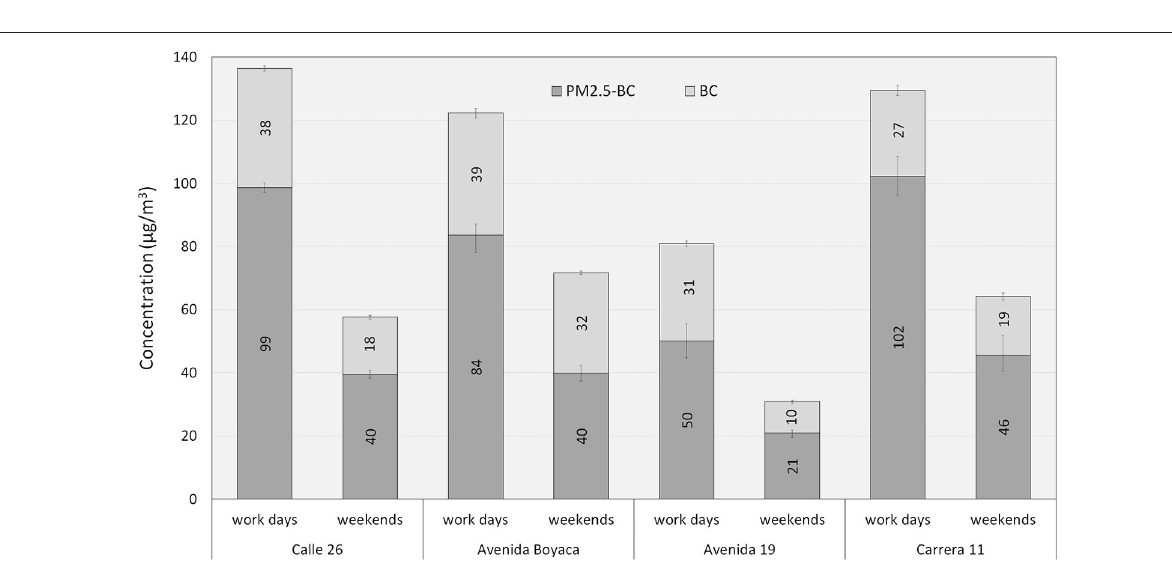
FIGURE 4 | Average concentrations and 95% confidence intervals for PM 2.5 ( µ g/m 3 ) and BC ( µ g/m 3 ) (all the bike-paths, classed by work days and